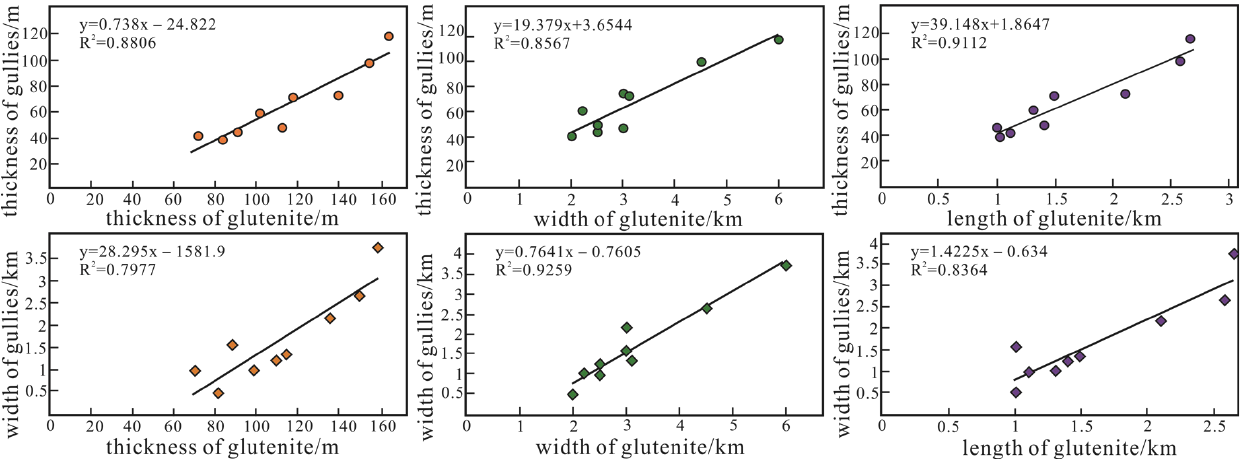
Figure 9. The relationship between incised valley depth and glutenite thickness, width, and length.